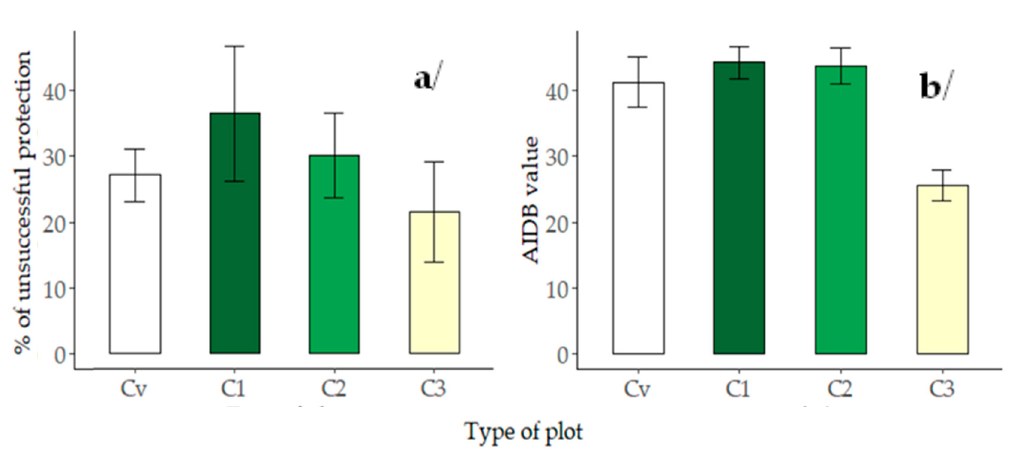
Figure 4. Multi-pathogen indicators observed in conventional and in-conversion plots. ( a ) Percentage of plants per plot showing unsuccessful protection strategies (assessment indicator of damage in bunches (AIDB) > 10%); ( b ) AIDB mean values in plots showing unsuccessful protection.